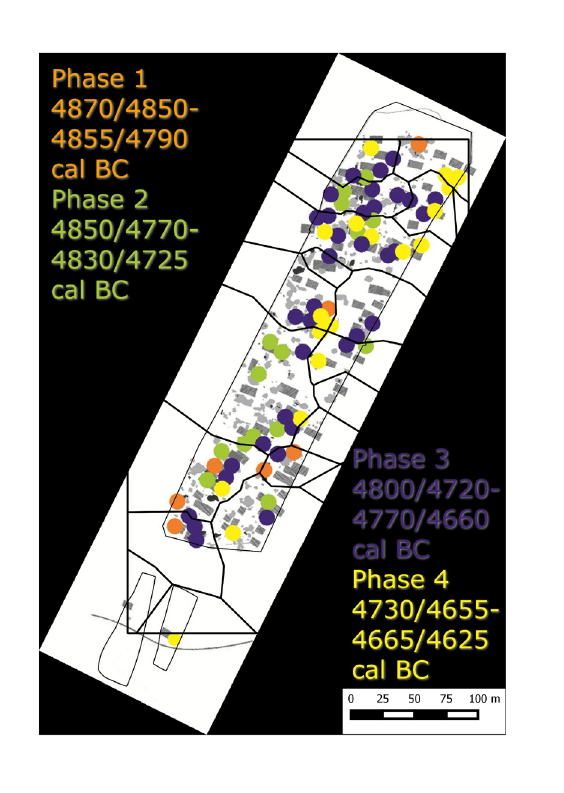
Figure 20: Distribution of the features with AMS dates and the house